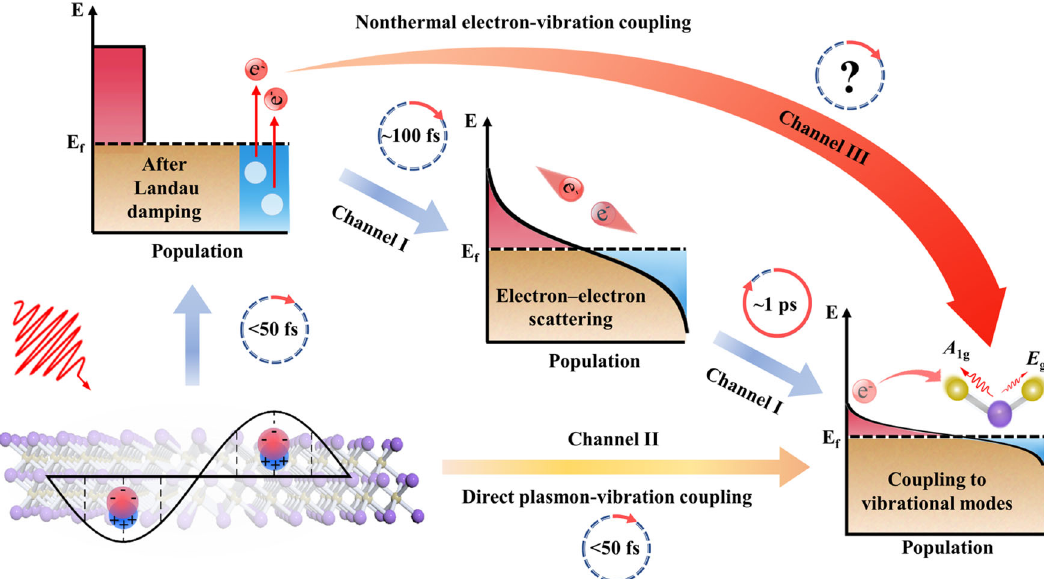
Fig. 1 | Schematic illustration ofthreedifferent surface plasmon(SP)-vibration coupling channels after opticalexcitation. Channel I: The SP decays to generate nonthermalelectronsafterLandaudamping,thenonthermalelectronsthenevolve into thermal electrons through the electron-electron scattering, and thermal